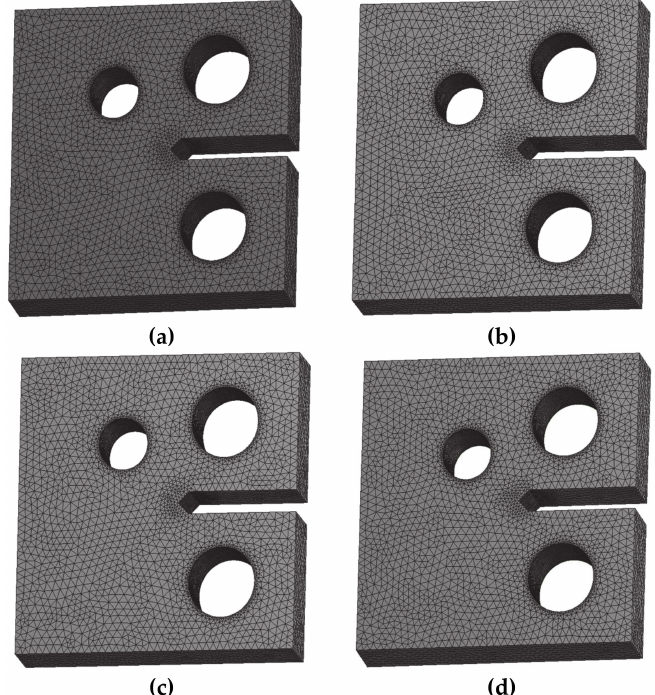
Figure 3. Finite element model for the MCTS, ( a ) CT01, ( b ) CT02, ( c ) CT03 and ( d ) CT04.